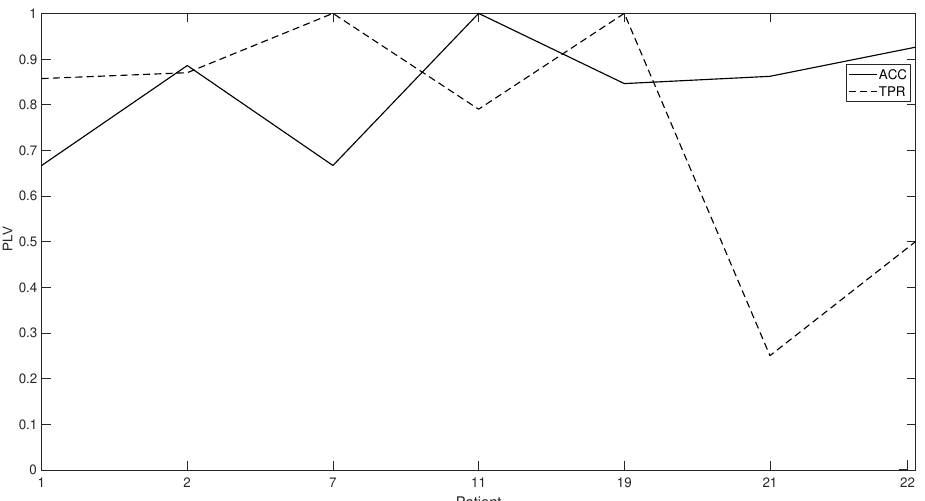
Figure 8. This figure shows the true positive rate (TPR) and accuracy (ACC) for patients 1, 2, 7, 11, 19, 21 and 22 for values σ = 7 and ρ =